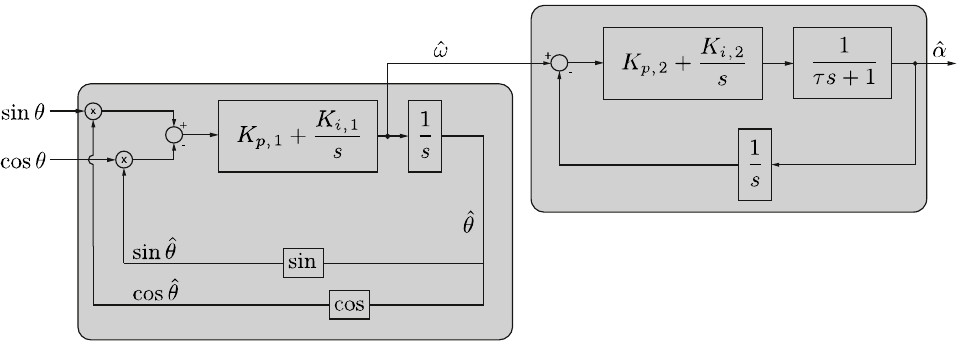
Figure 8. Dual-Phase-Locked Loop (PLL) scheme for estimation of angular speed and acceleration. Next, a comparison between the MT-method, PLL, and the proposed method (SinCos. RT) is carried out. To do so, a braking process given by the parabolic function ω ( t ) = 100 − 100 t 2 with the same default parameters used in the previous simulation was reproduced. Figure 9 shows the estimated angular speeds with the three methods.